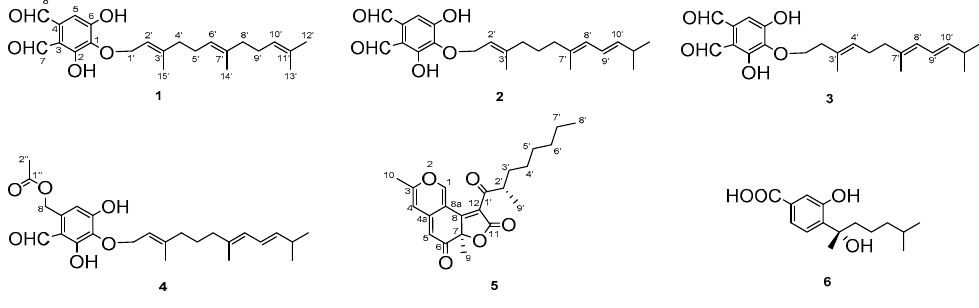
Figure 1. Structures of compounds 1 – 6 .